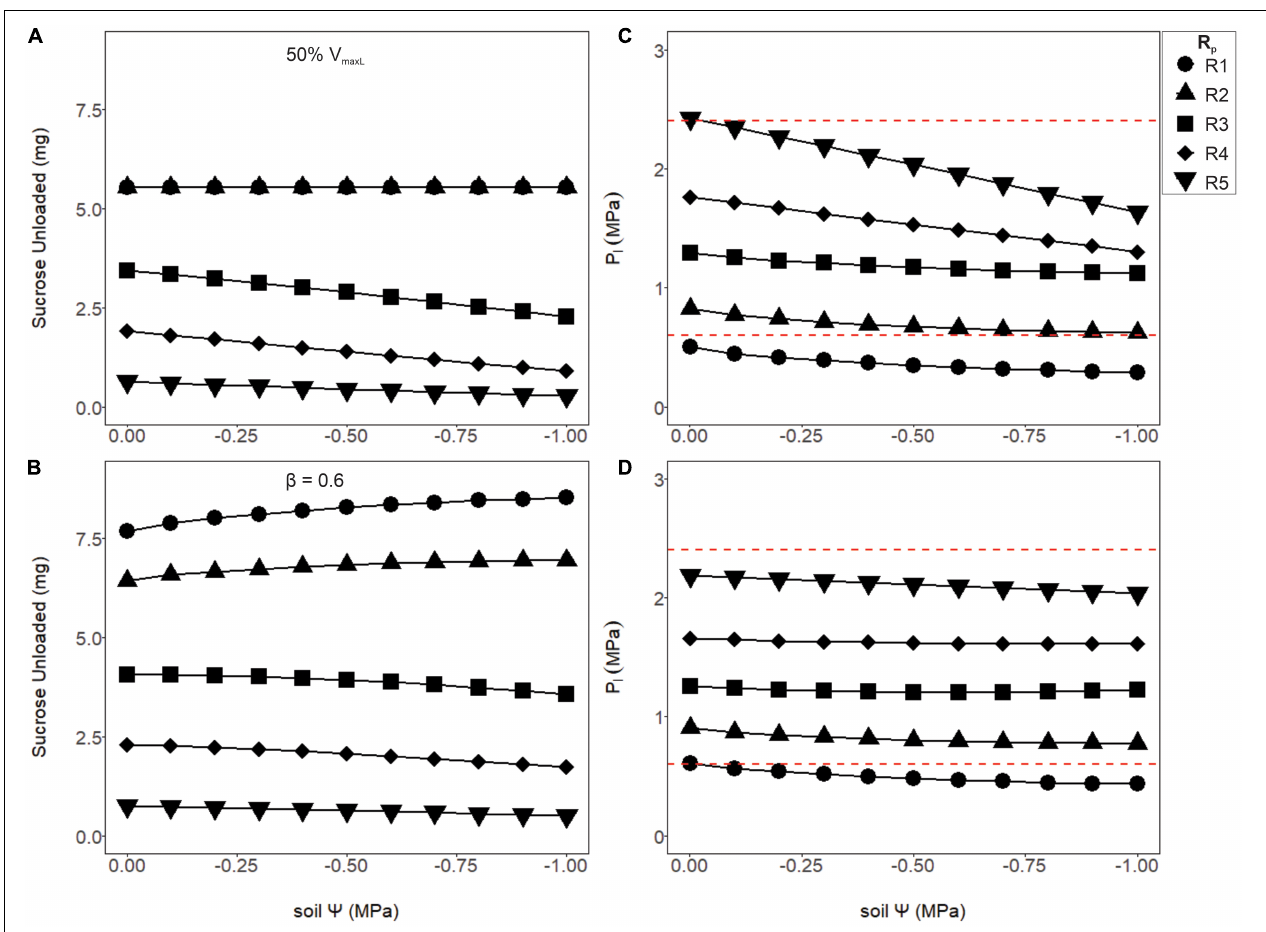
FIGURE 6 | The amount of sucrose unloaded or phloem pressure in the loading zone (P 1 ) as a function of soil water potential ( (cid:57) s ) for two differing loading rate scenarios: a 50% reduction in V maxL (A,C) or a pressure regulated reduction in the default VmaxL, with a downregulation strength of β = 0.6 ( B,D ; see Eq. 18). The first scenario (A,C) shows the amount of sucrose unloaded and P 1 for a 50% reduction in V maxL . Output remained stable over the drought for R1 and R2 and began to decline with soil water for R3–R5. Meanwhile, phloem pressure began to fall with drier soils, with most R p values falling within the empirical pressure window, except for the lowest pathway resistance which was under-pressured. (B,D) Using pressure downregulated loading, sucrose output slightly improved as the soil dried for lower R p values (R1 and R2) but started to decline with higher values (R3–R5). Downregulation of loading allowed most of the tested resistances (R2–R5) to have phloem pressures within empirical bounds. Red dashed lines signify phloem pressure potentials recorded previously empirically (0.6–2.4